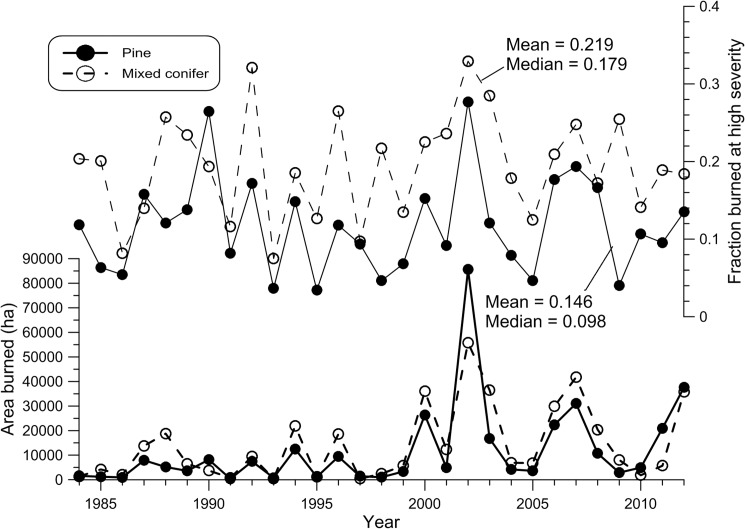
Trends between 1984–2012 in area burned at high severity (bottom) and fraction burned at high severity (top).Results are shown for both dry pine and dry mixed conifer forests.